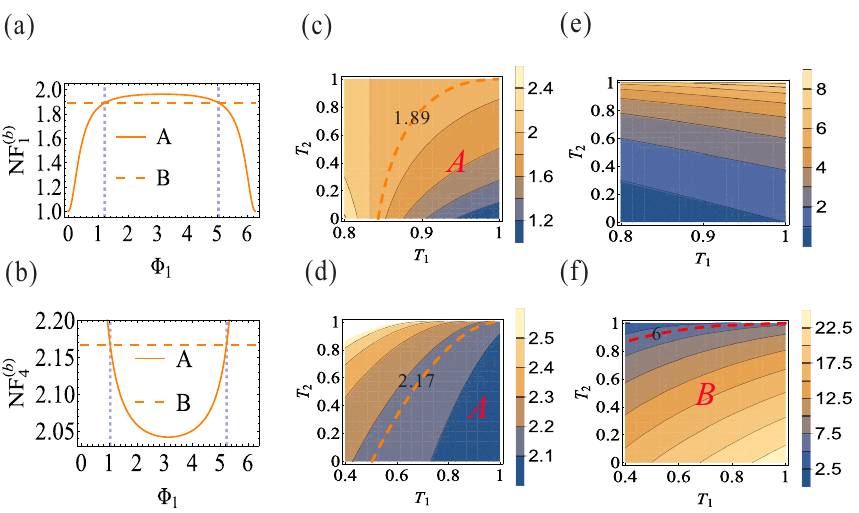
( b ) ( b ) Figure 2. The dependence of NF and NF in Equation (6) on Φ 1 under the condition of T 1 = 1 1 4 and T 2 = 0 (traces A in ( a , b )), and T 1 and T 2 under the condition of Φ 1 = 0 ( Φ 1 = π ) in ( c , d ). ( b ) ( b ) The dependence of G and G in Equation (7) on T 1 and T 2 under the condition of Φ 1 = 0 1 4 ( Φ 1 = π ) in ( e , f ). The orange and red dashed lines in all the figures are the NF values and gain values, respectively, from the symmetrical FWM processes without the correlation injection scheme in Figure 1a. The vertical blue dashed lines in ( a , b ) are Φ 1 = ( 1.23, 5.05) and Φ 1 = ( 1.05, 5.24), respectively. All the above figures are obtained for the case of G 1 = G 2 =